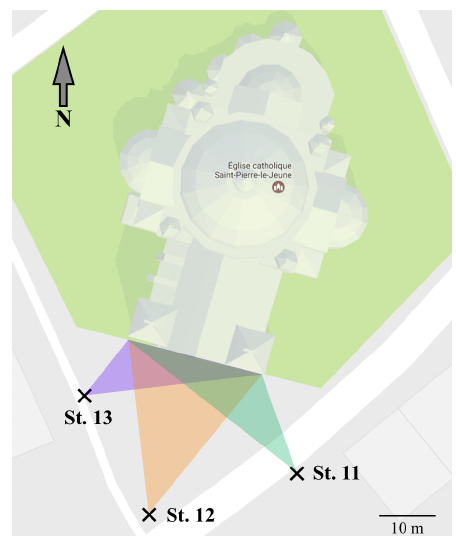
Figure 3. Location of the three scanning stations in front of the facade (map from Google Maps, modified)